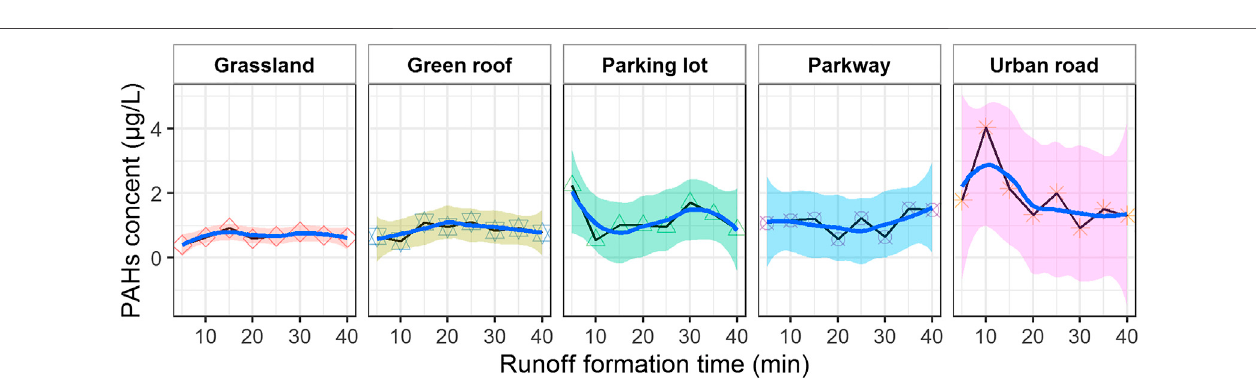
FIGURE 4 | PAH average concentration index changes over time in stormwater and runoff events. The smoothing blue curve was obtained by loess method, and the corresponding color shadow part was its 95% con fi dence interval.